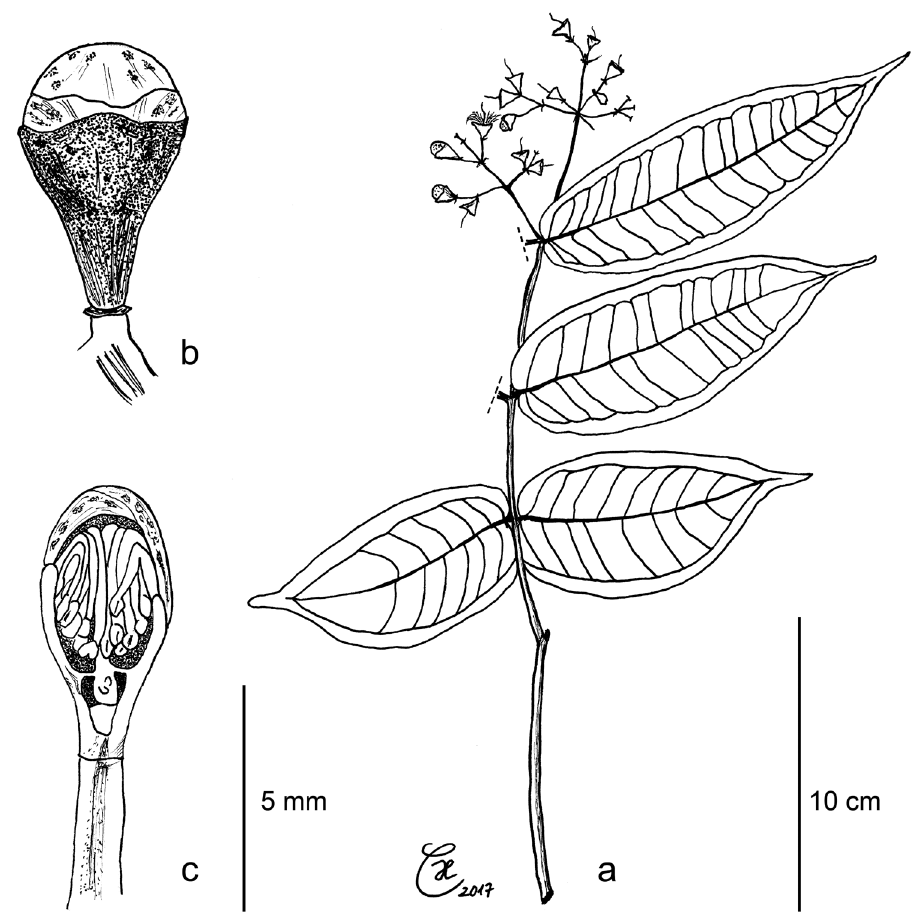
Figure 3. Syzygium contiguum: a leafy twig with flowers in different developmental stages b flower bud with gland-dotted petals and shallow calyx lobes c flower bud, longitudinal section. All from holotype Culmsee